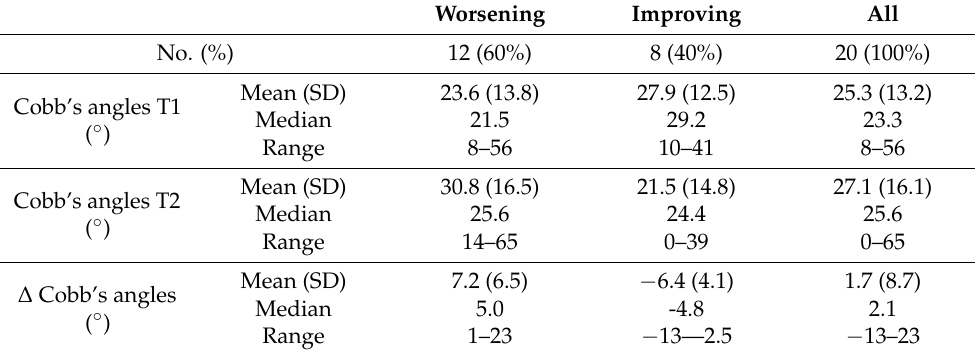
Table 2. Descriptive statistics of participants’ Cobb’s angles at T1 and T2 divided between those whose scoliosis worsened, those whose curve improved, and all participants together. Delta ( ∆ ) Cobb’s angles represent the simple difference between Cobb’s angle measured at T2 and T1. Positive values represent a worsening, while negative values represent an improvement in the scoliotic curve.